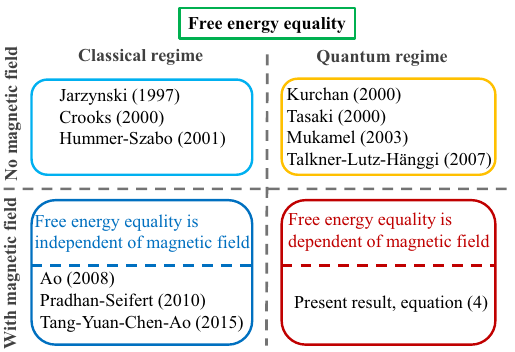
Fig. 4 A brief summary of historical developments of the free energy equalities. They include the cases without (classical regime: 1,2,15 , quantum regime: 21 – 24 ) and with a magnetic fi eld 17 – 19 . The free energy equality is independent of magnetism in the classical regime but becomes dependent on the quantum